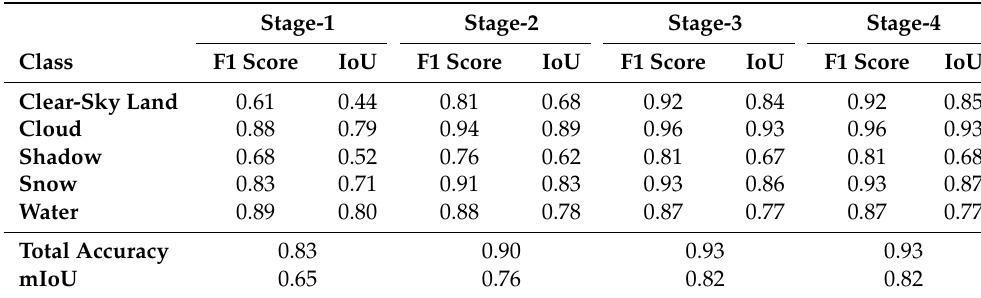
Table 10. Comparison of F1 score and IoU across the trained models from different stages of the self-training framework.